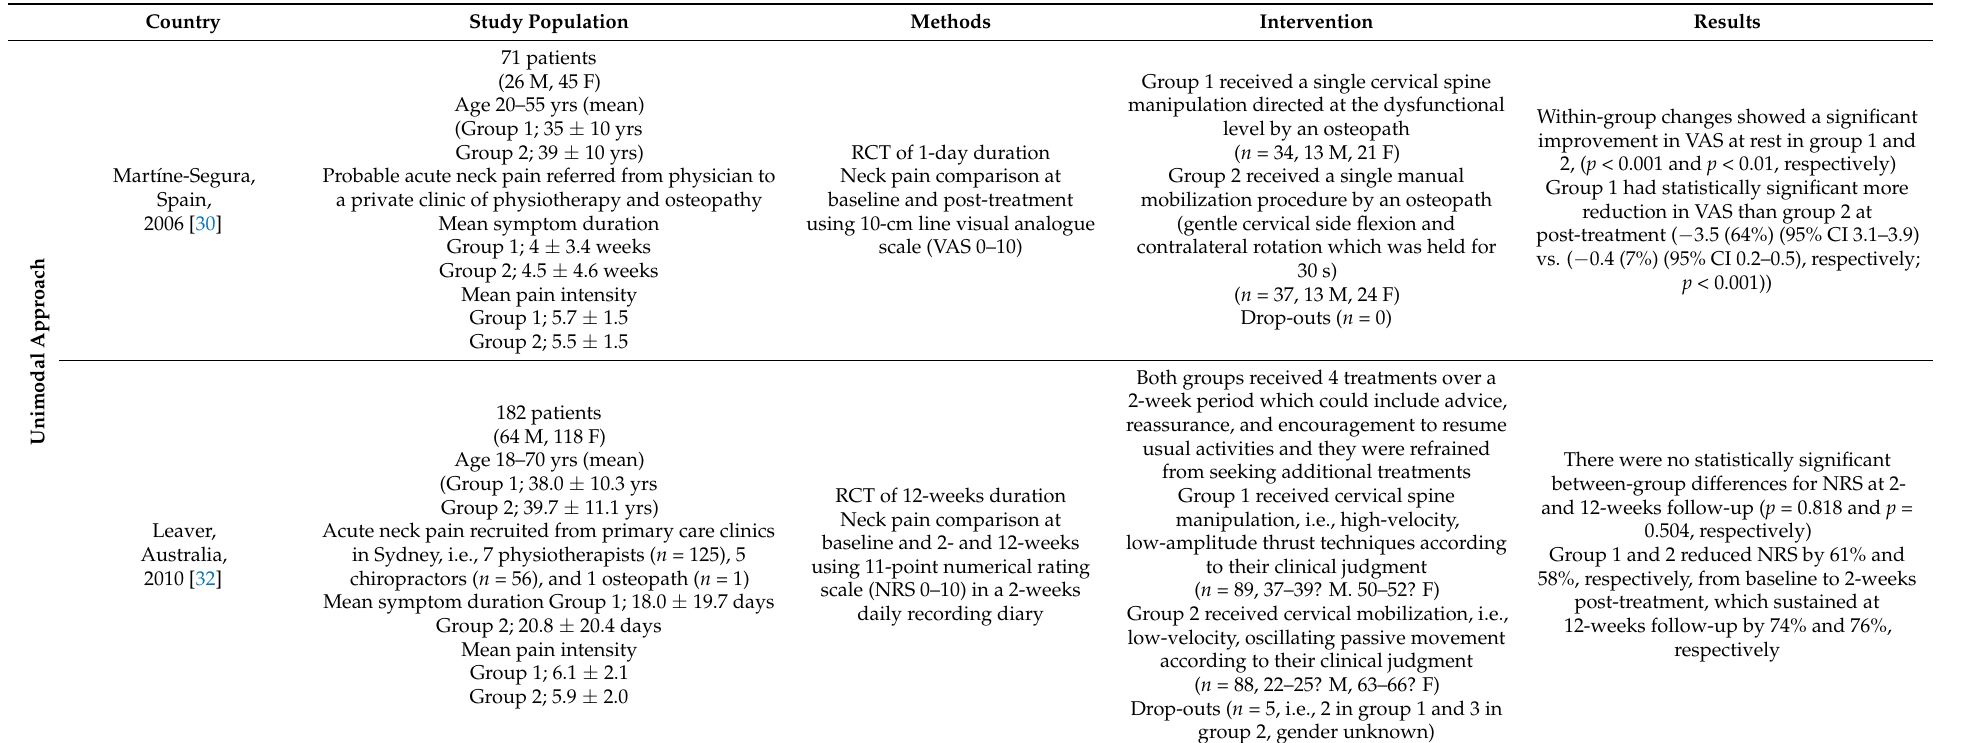
Table 2. Results from randomized clinical trials focused on pain intensity of spinal manipulative